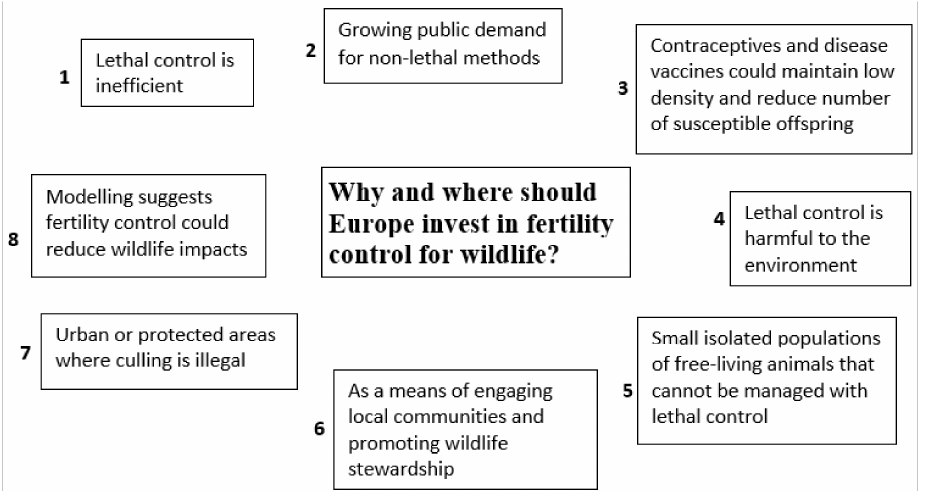
Figure 2. Reasons and contexts for Europe to invest in research on wildlife fertility control to mitigate wildlife impacts. ”Wildlife” includes wild mammals and bird species and feral